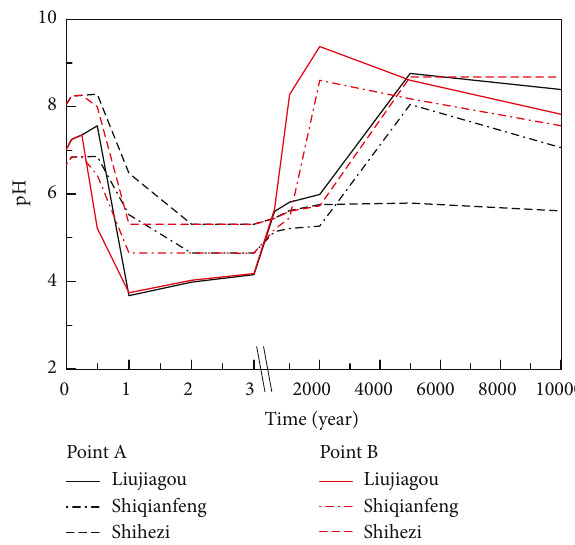
Figure 6: The evolution of pH at point A and point B for the Liujiagou, Shiqianfeng, and Shihezi formations over